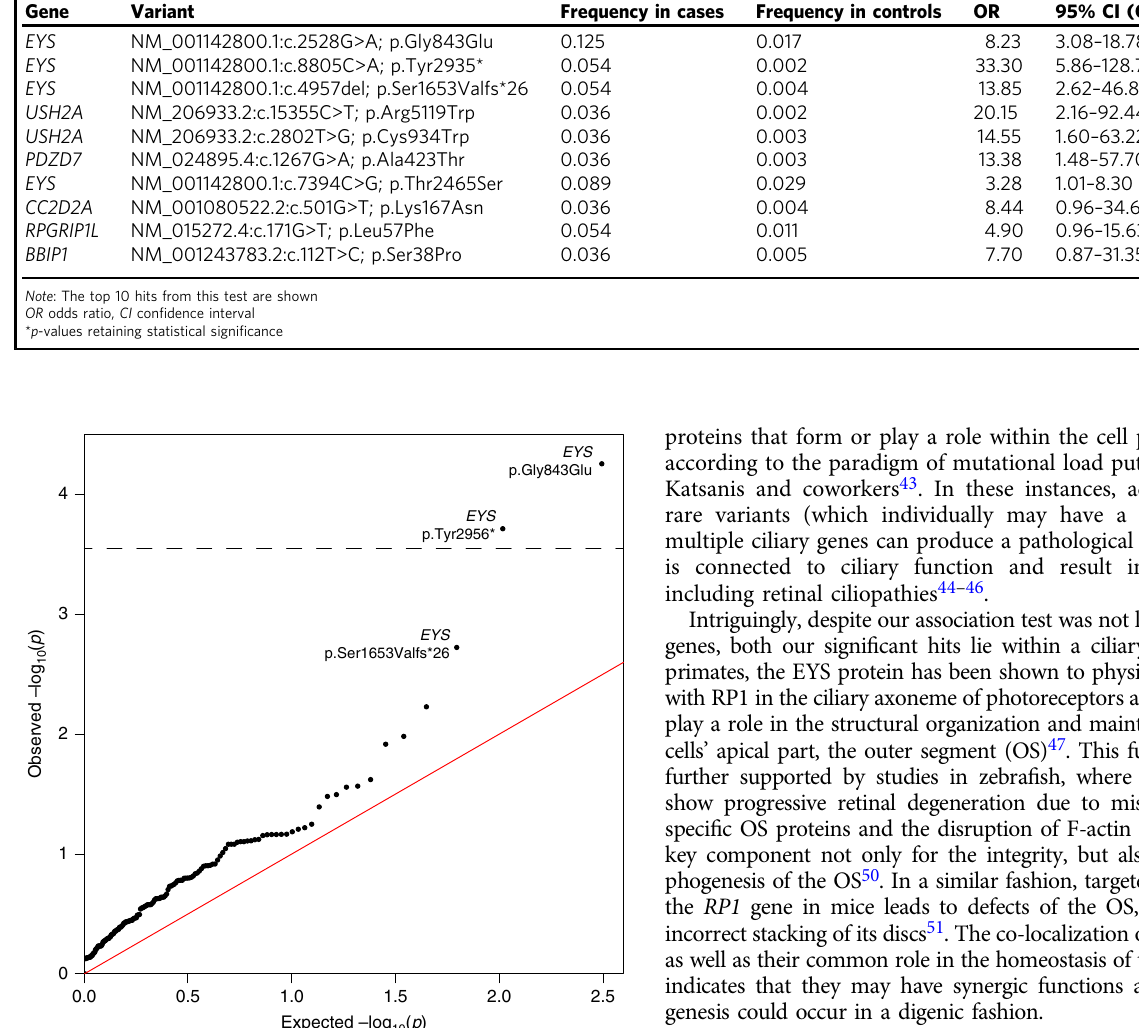
Table 1 Summary of the results of the association study Gene Variant